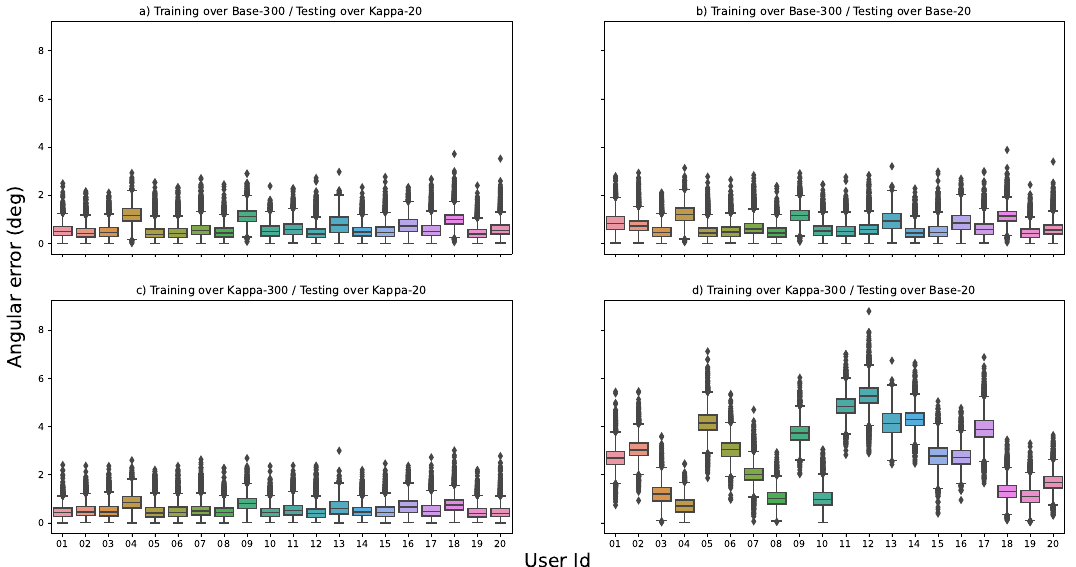
Figure 7. Boxplot representations of the results obtained for the theoretical framework experiments. The figures share the same X and Y axes. The X axis corresponds to the user Id from which each boxplot is computed. The Y axis is the angular error in degrees. ( a ) Results obtained when training over U2Eyes-Base-300 and testing over U2Eyes-Kappa-20. ( b ) Results obtained when training over U2Eyes-Base-300 and testing over U2Eyes-Base-20. ( c ) Results obtained when training over U2Eyes-Kappa-300 and testing over U2Eyes-Kappa-20. ( d ) Results obtained when training over U2Eyes-Kappa-300 and testing over